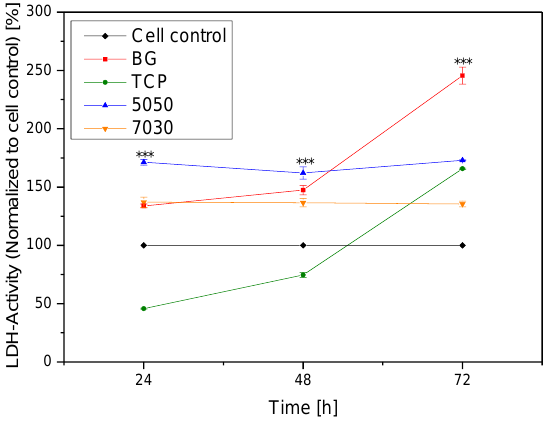
Figure 9. LDH Activity of MG-63 cells on the samples measured after 24, 48 and 72 h using LDH (normalized to cell control). Significant difference *** ( p = 0.001), ( n = 30).